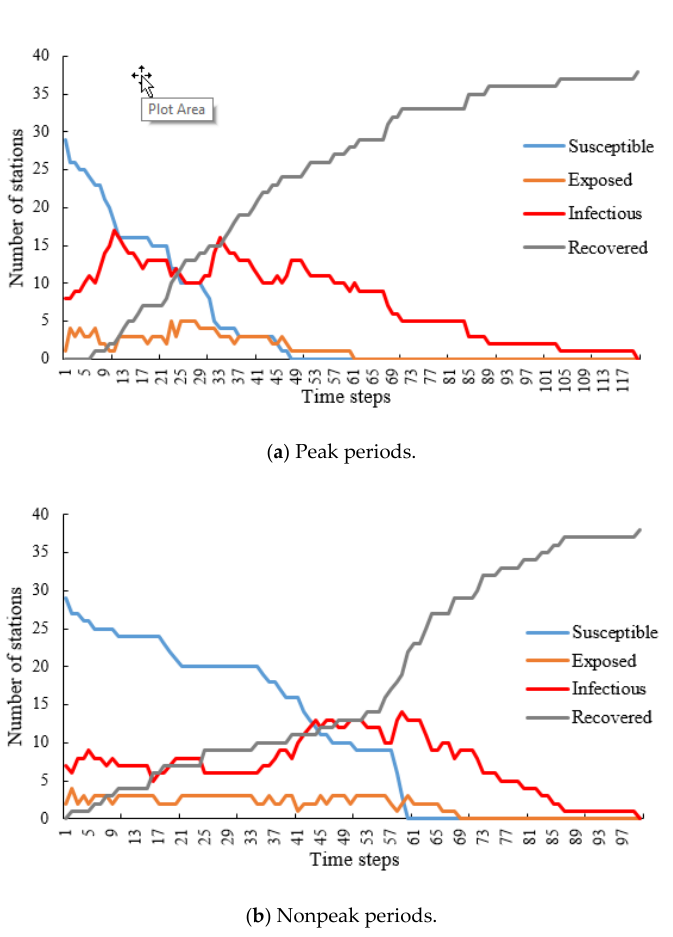
Figure 11. Congestion propagation during peak and nonpeak periods.